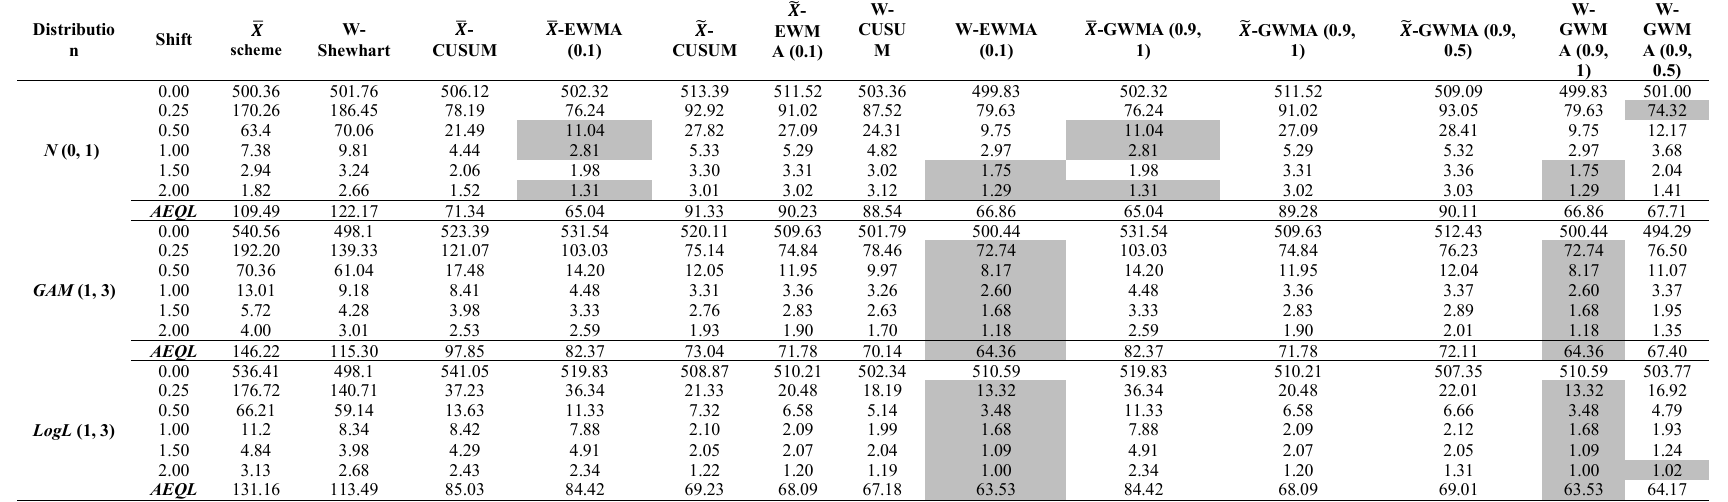
of 500 (cid:2868)